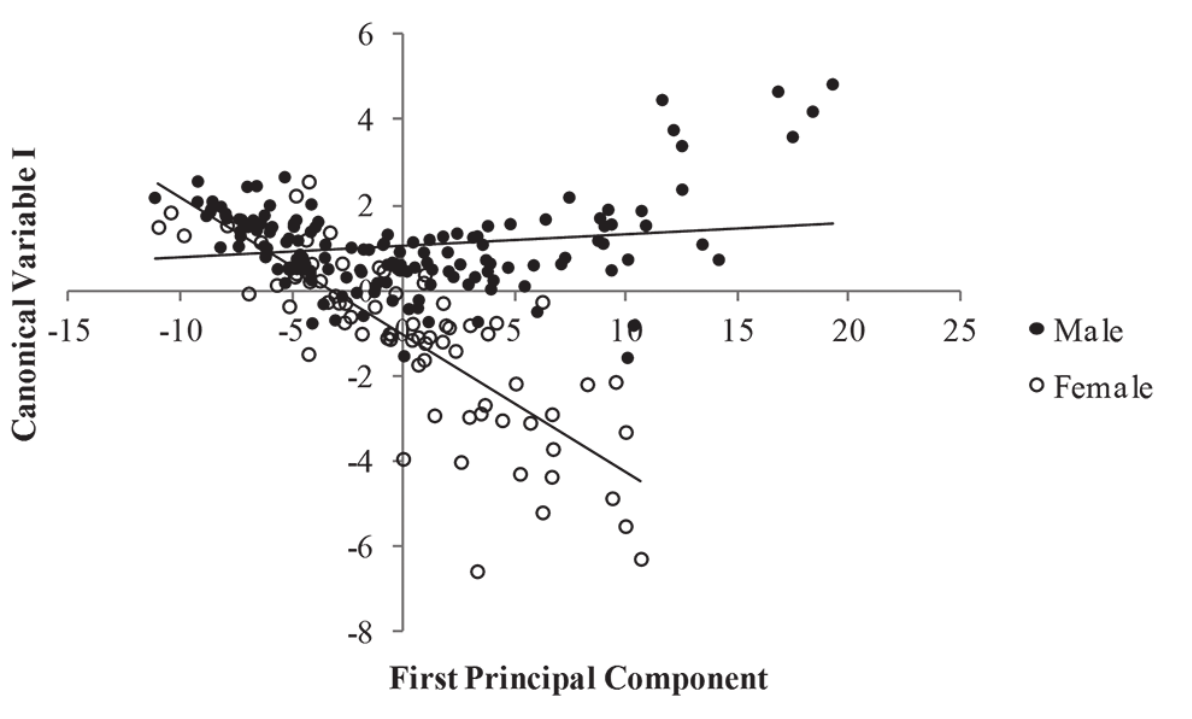
Figure 2. Relationship between the scores and the generalized size (first principal component) in individuals of both sexes of Aegla marginata . The scores were obtained using canonical discriminant